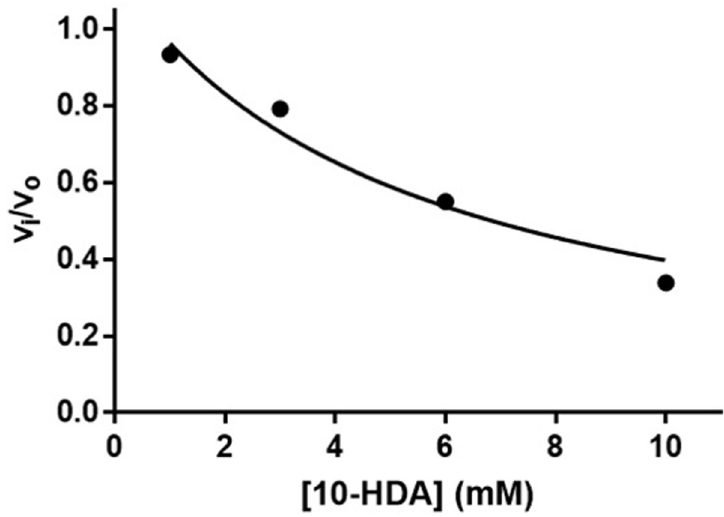
Fig 4. 10-HDA inhibition of HDAC3:NCOR2. A solution containing Fluor de Lys SIRT1 substrate (1 μ M final concentration) and 10 mM KCl (final concentration) was added to 5 nM HDAC3:NCOR2 (final concentration) in 25 mM Tris pH 8 with 500 μ M EDTA. Initial velocities were determined from fluorescence changes over time, normalized, plotted versus 10-HDA concentration, and fit using Eq 2.